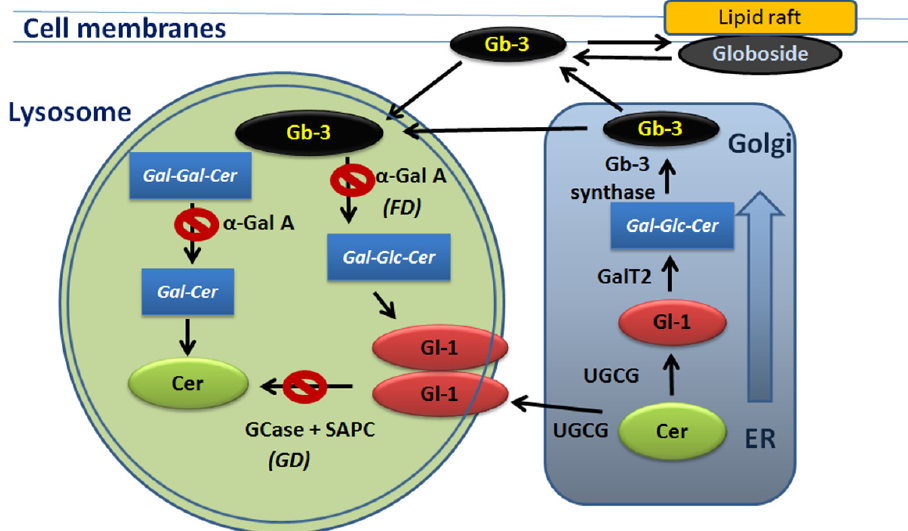
Figure 1. Sphingolipid metabolism in Gaucher and Fabry diseases (GD, FD). Ceramide (Cer), Figure glucosylceramide (Gl-1) and globotriaosylceramide (Gb-3) shifts between endoplasmic reticulum ER, Golgi apparatus, lysosomes, and cellular membranes. UDP-Glucose Ceramide Glucosyltransferase ( UGCG) converts Cer to Gl-1 in the ER. Gl-1 localized in the intralysosomal